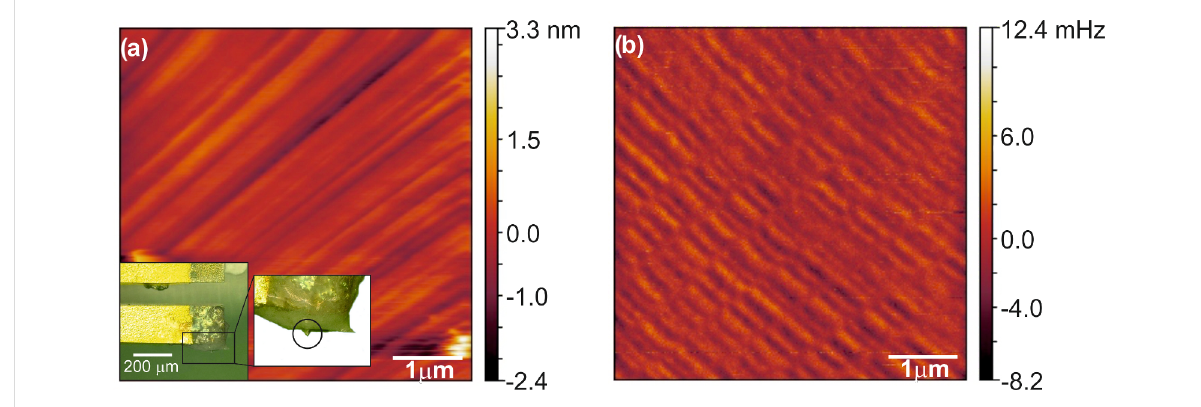
Figure 3: Lift Mode FM-MFM image employing a qPlus sensor with a commercial cobalt-coated MFM cantilever tip attached to it (see inset in a). Flat- tened raw data with imaging parameters f 0 = 32517 Hz, k = 1800 Nm − 1 , Q = 1870, A = 25 nm and lift height 35 nm. (a) Topography and (b) lift-mode frequency